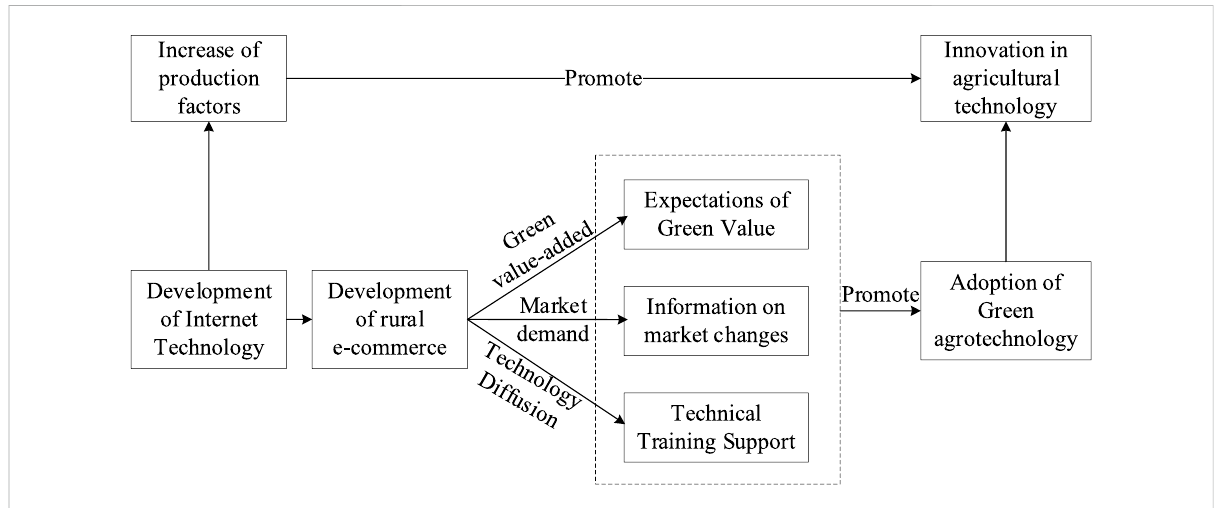
FIGURE 1 Analytical framework based on induced agricultural technological innovation theory.